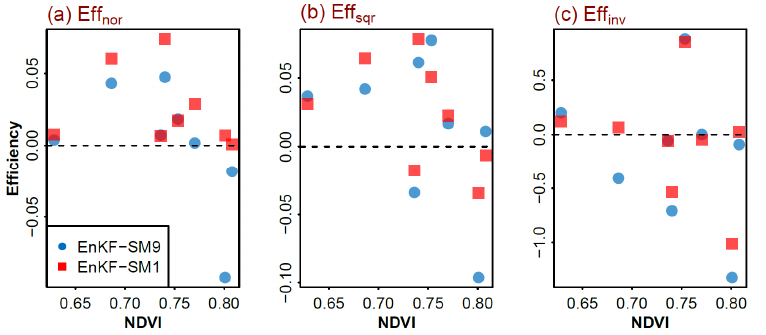
Figure 10. Relationship between efficiency of data assimilation for ( a ) Ef f nor (high flow score); ( b ) Ef f sqr (average flow score); and ( c ) Ef f inv (low flow score) time series with average NDVI values over eight catchments.